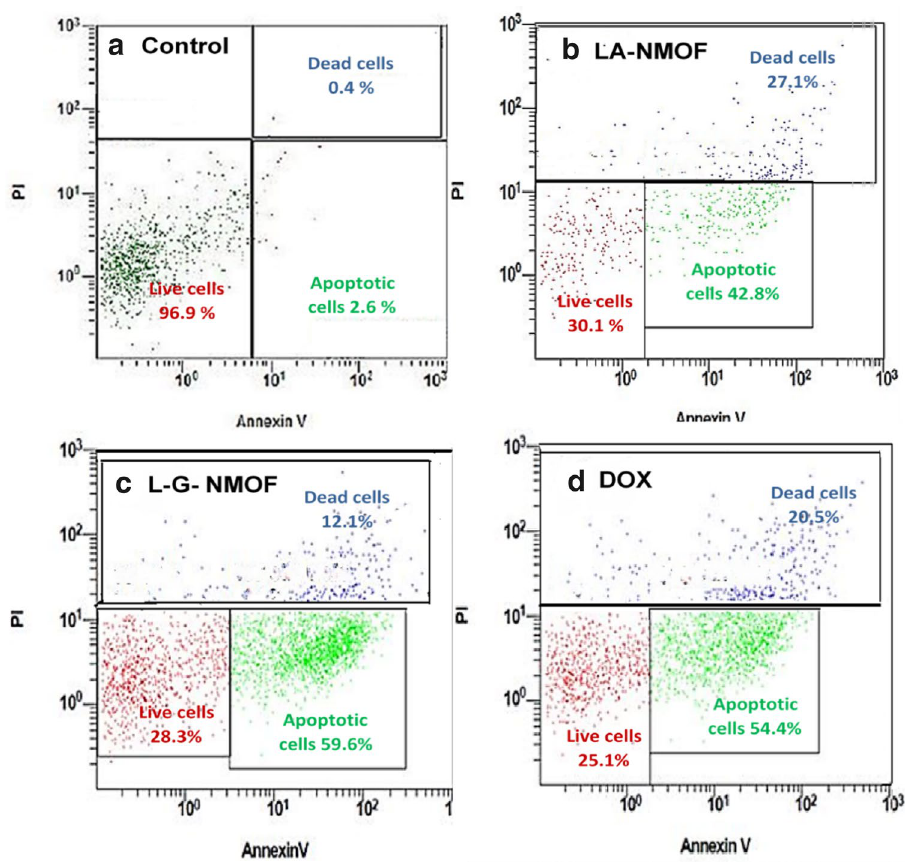
Figure 7. Flow cytometric histograms of ( a ) untreated HepG2 cell lines, ( b ) HepG2 cell lines treated with LA-NMOF-DOX, ( c ) HepG2 cell lines treated with LA-GA-NMOF-DOX, and ( d ) HepG2 cell lines treated with free